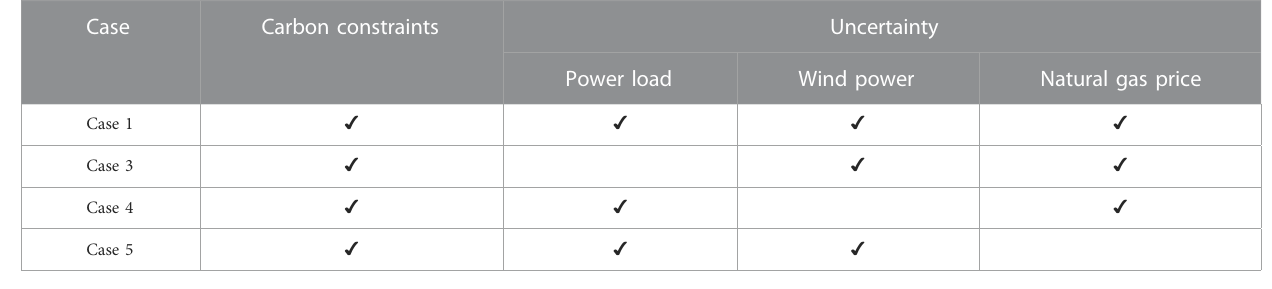
TABLE 9 Robustness analysis cases.